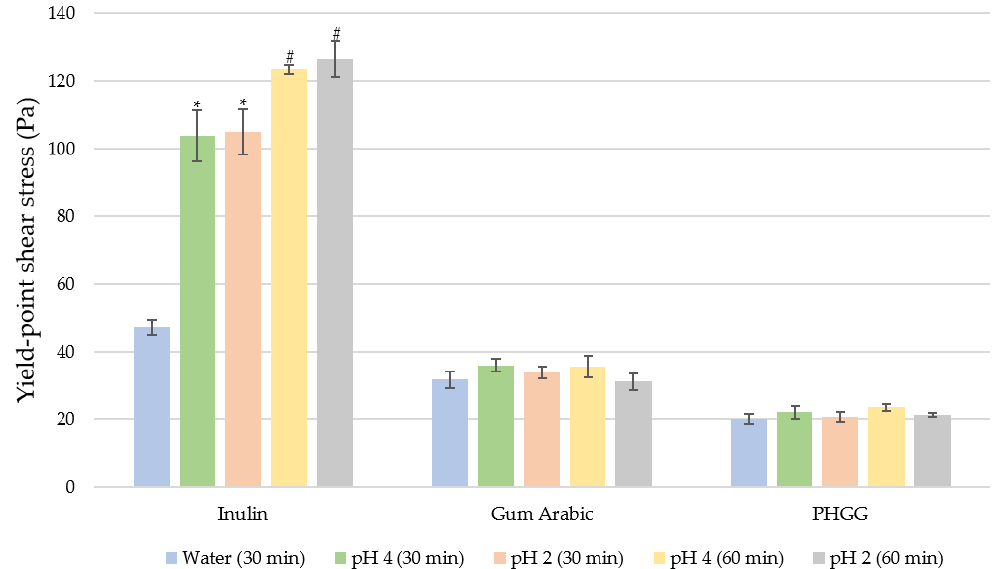
Figure 6. Comparisons of yield-point shear stresses of three ‘low-viscosity’ fibres; inulin, gum Arabic, and partially hydrolysed guar gum (PHGG) at 1000 mg/mL. Test conditions are in distilled water (pH 7), and simulated digestion at pH 4 and pH 2. The data tip (*) indicates significant difference between the distilled water condition and the simulated digestion condition (pH 4 or pH 2) at 30 min. The data tip (#) indicates significant difference between the simulated digestion condition at 30 min (pH 4 or pH 2) and its corresponding simulated digestion condition at 60 min. The significance level is p ≤ 0.05 for both (*) and (#).